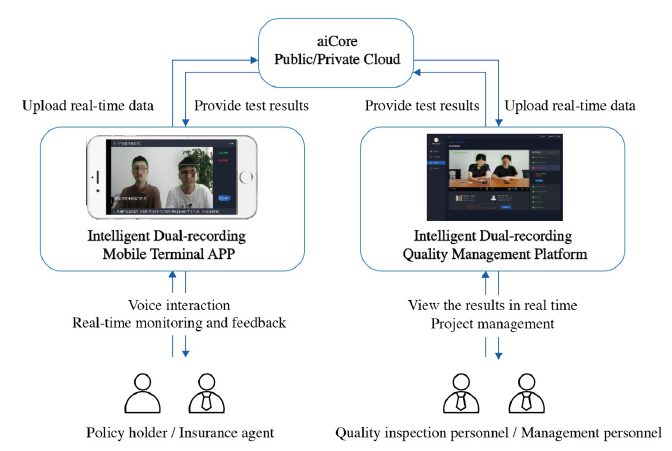
Fig. 4 aiCore intelligent dual-recording solution interaction